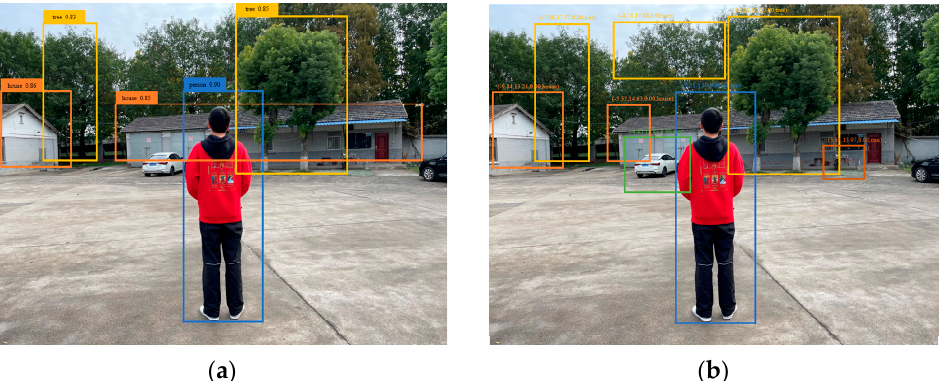
Table 3. Target categories and quantities.